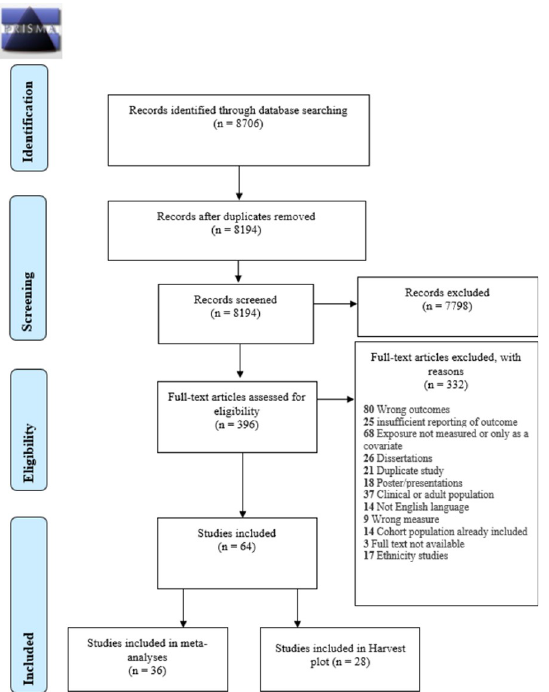
Fig 2. PRISMA 2009 flow diagram for all included